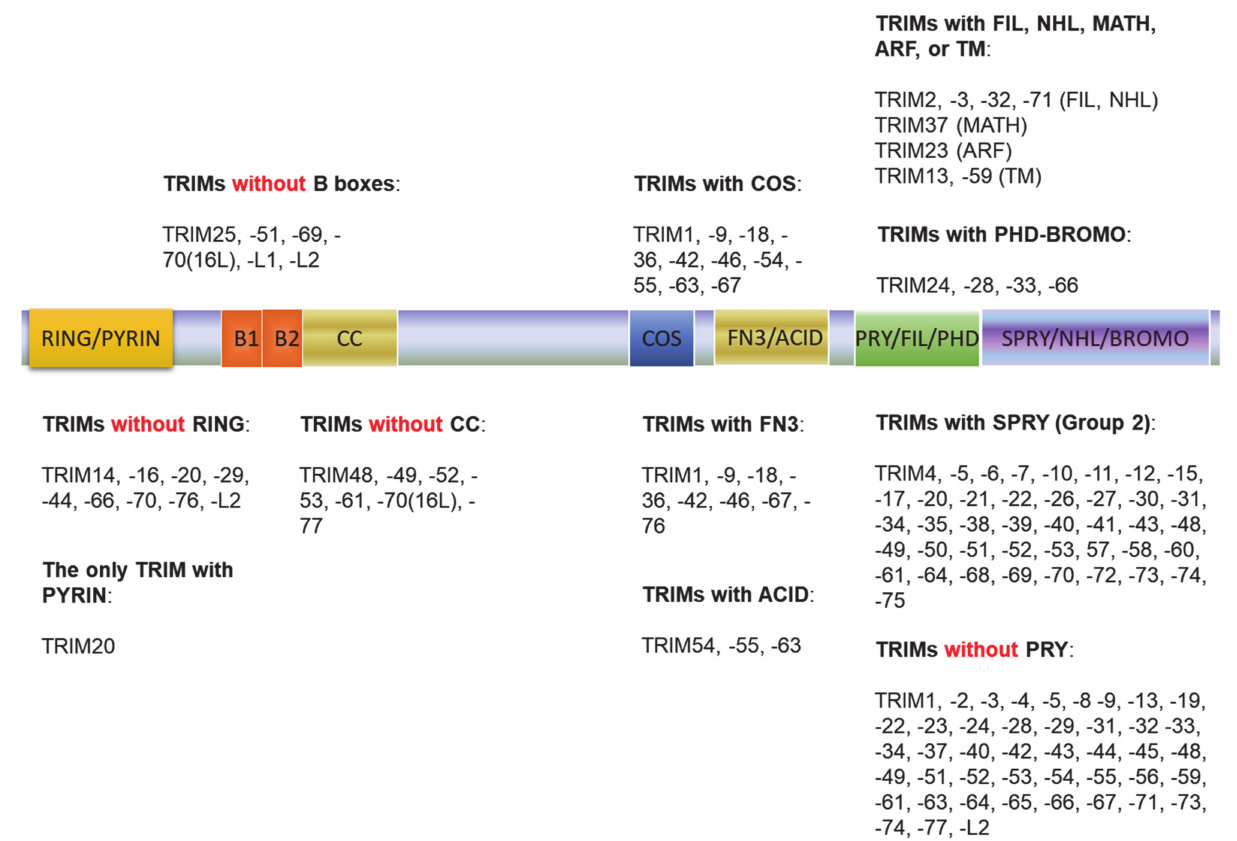
Figure 2. The tripartite motif (TRIM) family protein domain alignment. The TRIM family includes at least 80 members in humans. The N-terminal TRIM motif includes the conserved RBCC domain that comprises of three subdomains: 1 RING domain that confers with E3 ligase activity (8 TRIMs in humans do not have the RING domain), 0~2 B-box ZNF domains (B1+B2 or B2 alone), and 0~1 coil–coil region that is associated with B-boxes. According to the diversity of the C-terminuses and genomic organization, TRIM proteins are grouped into Group1 and Group 2. Members in Group 1 possess a variety of C-terminal domains (COS, FN3, ACID, PRY, PHD-BROMO, FIL, NHL, MATH, ARF, and TM) and exist in both vertebrate and invertebrates, and those in Group 2 possess a C-terminal SPRY domain, and they are absent in